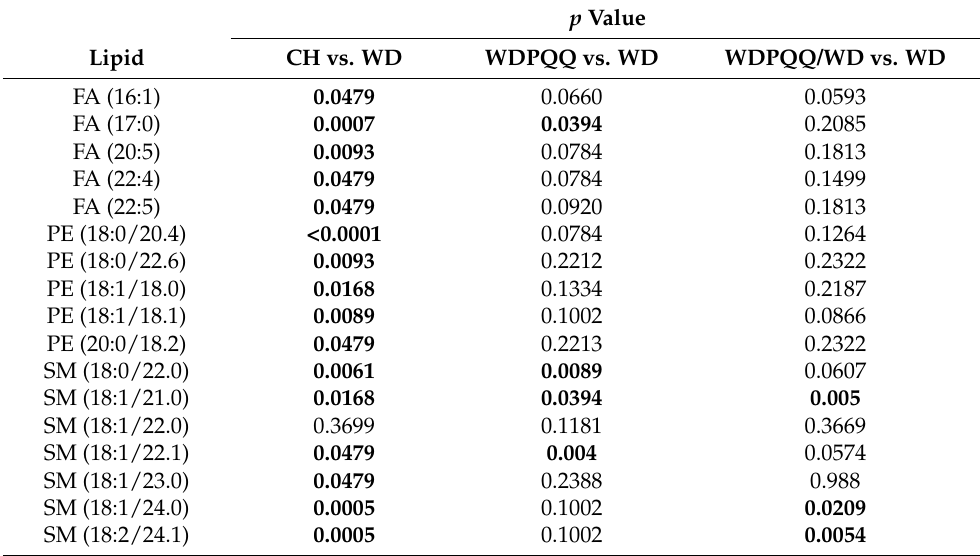
Table 2. t -tests with Welch’s correction of top lipids affected by PQQ in adult